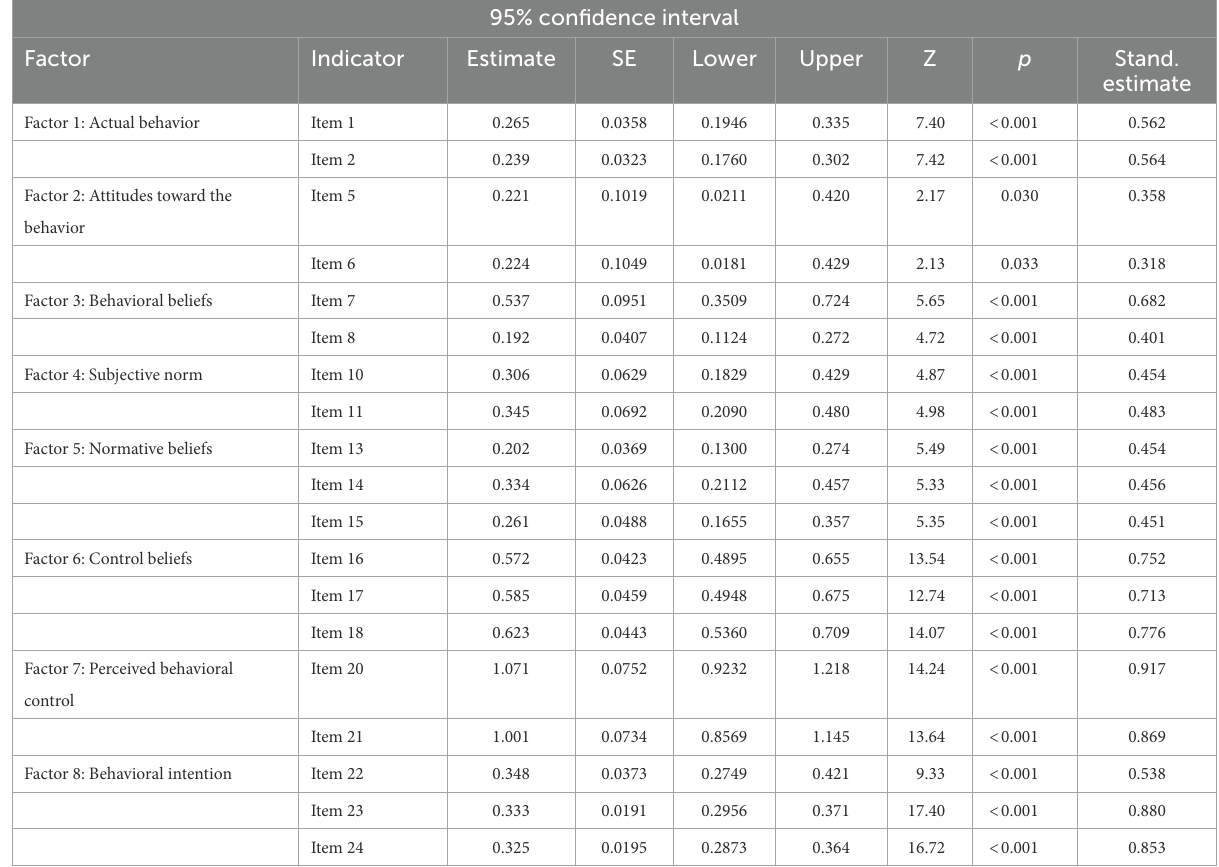
TABLE 1 Confirmatory factor analysis results for IQIB-ECEC 19-item scale.